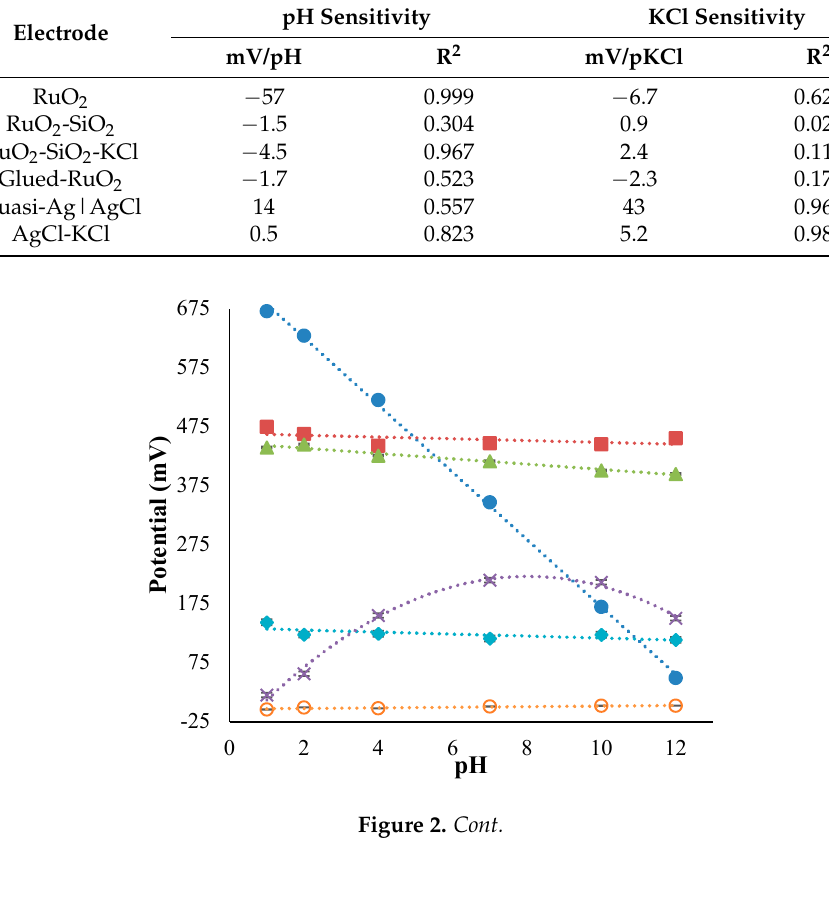
Table 2. Summary of approximate pH and KCl sensitivity values for the manufactured electrodes. Electrode names are color coded to match their respective data series in Figure 2.